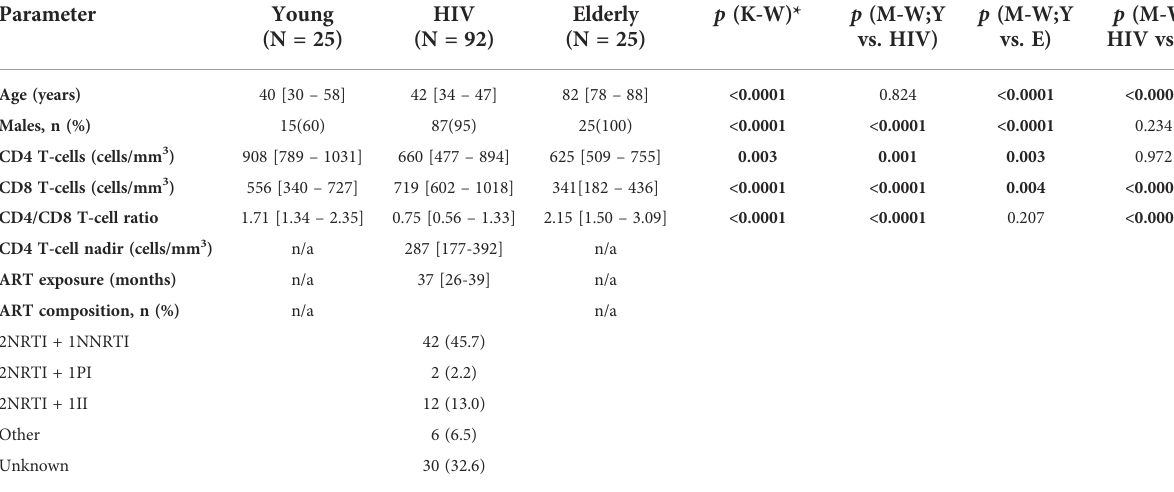
TABLE 1 Characteristics of the study